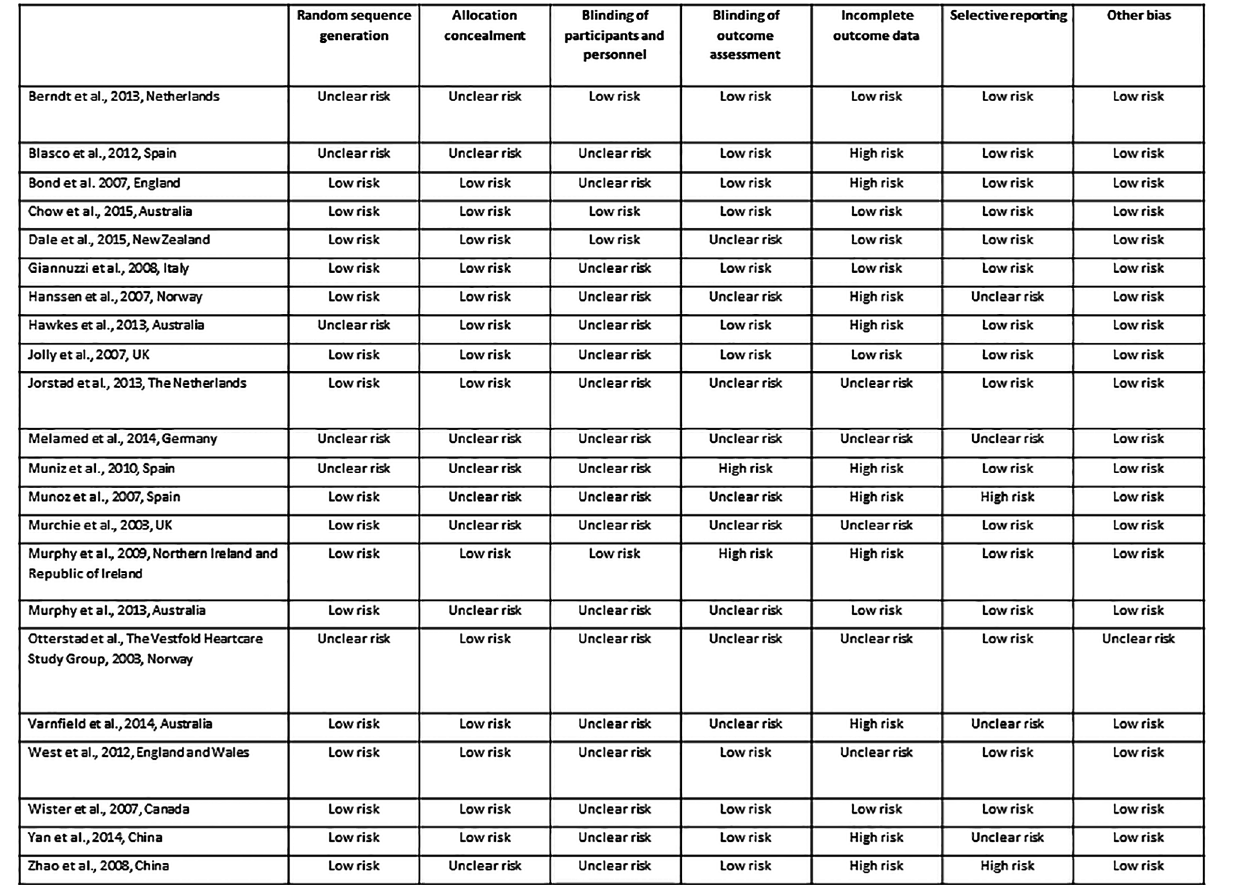
Fig 6. Risk of bias summary for all individual